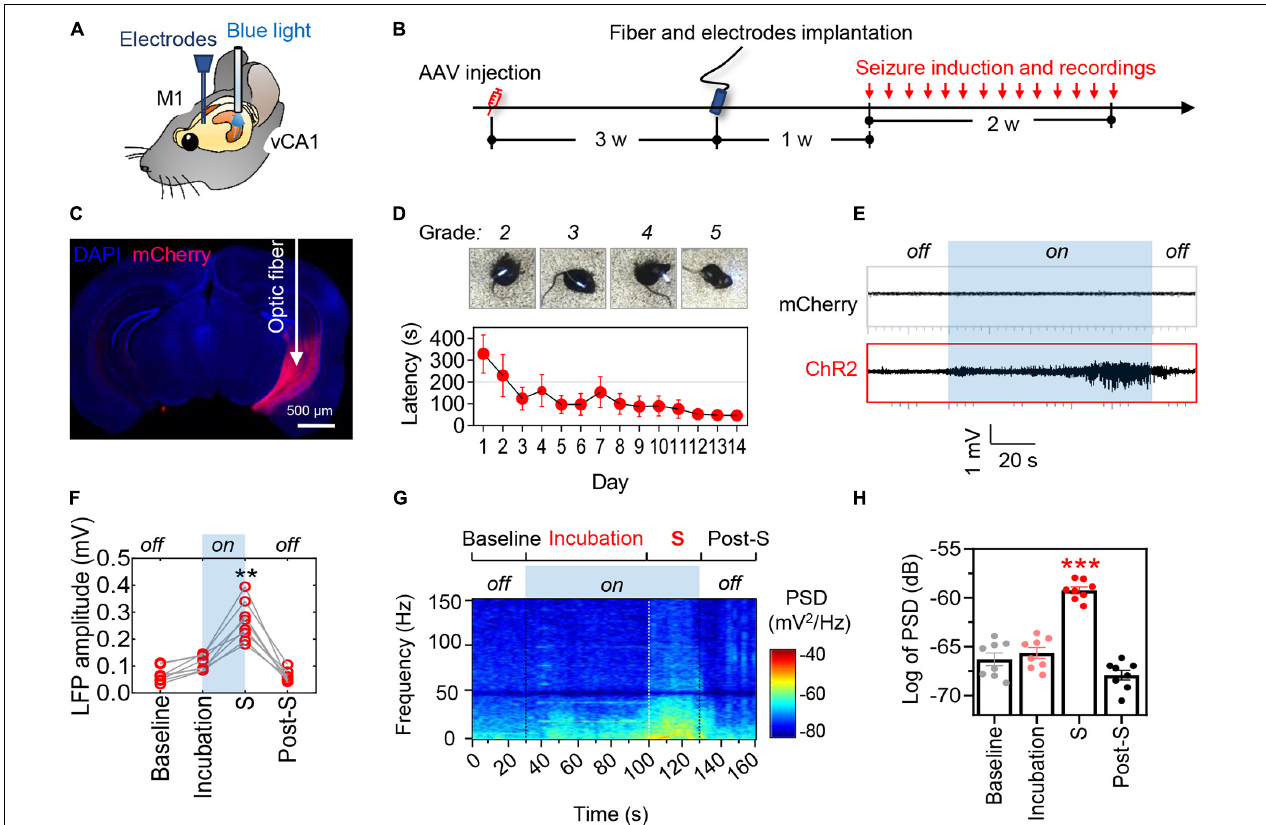
FIGURE 1 | Optogenetic stimulation of ventral hippocampal excitatory neurons induces controllable epileptic seizures. (A) Schematic illustrates the locations of optic fiber and recording electrode. (B) Experimental procedures of virus injection, optic fiber and electrode implantation, optogenetic seizure induction. (C) A representative image showing the AAVs-mediated mCherry expression in the ventral hippocampus. Scale bar, 500 µ m. (D) The representative images show typical seizure behavior (MRS stages 2–5) and the latency to generalized seizures (upper) . Repeated optogenetic stimulation of vCA1 excitatory neurons induced typical seizure behavior, and the latency to generalized seizures was decreasing during repeated induction that showed seizure threshold declined over time (bottom). (E,F) Optogenetic hyperactivation of vCA1 excitatory neurons (i.e., blue light on) induced epileptiform neuronal activities in the primary motor cortex (M1). The local field potential (LFP) amplitude in M1 significantly increased during the phase of incubation and generalized seizures (shortened as S). The mice injected with AAV-mCherry were tested as non-seizure controls. Repeat-measures one-way ANOVA followed by Tukey multiple-comparisons tests, ** p < 0.01, *** p < 0.001, compared with the baseline, n = 8 in each group. (G,H) Optogenetic induction of seizures increased the power spectra density (PSD) of LFP in the phase of incubation and generalized seizures. Repeated-measures one-way ANOVA followed by Tukey multiple-comparisons tests. ** p < 0.01, *** p < 0.001, compared with the baseline, n = 8 in each group. Values are presented as the mean ±